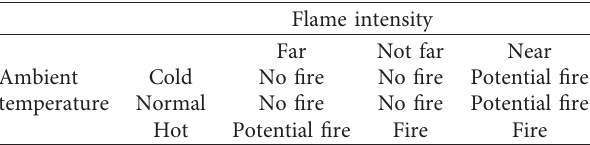
Table 1: Rules for fire status when the smoke is low.